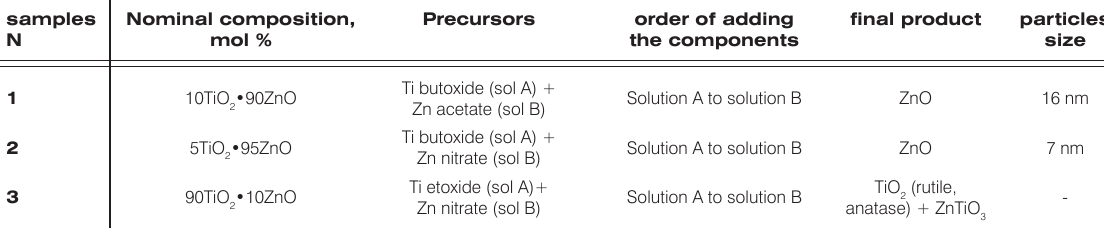
Table 1. Samples obtained by combustion gel